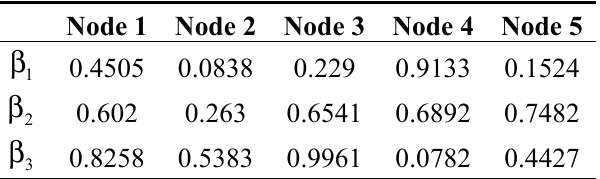
Table 5. The cross-layer